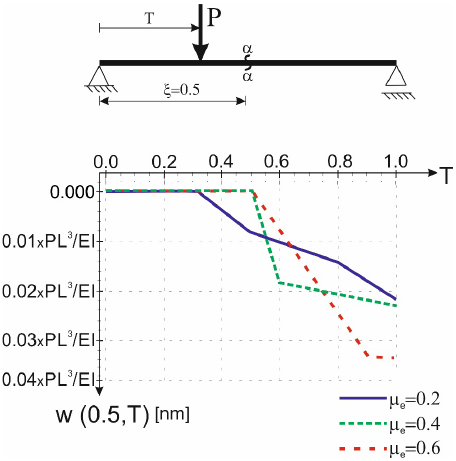
Figure 12: Stress gradient model. Vibrations of the beam in the middle cross section if 0.10 g η =